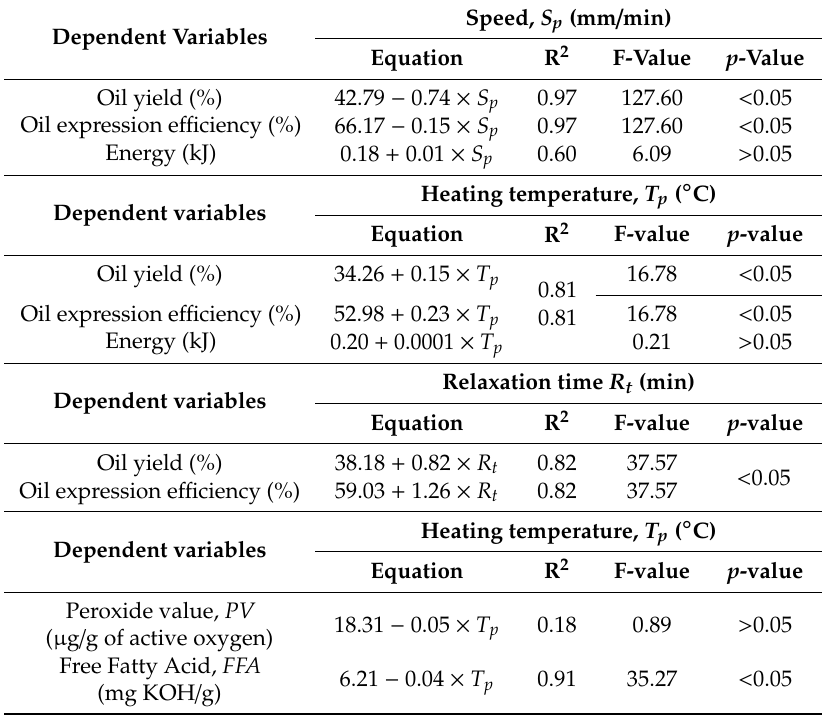
Table 10. Regression results of the e ff ects of speed, heating temperature, and relaxation